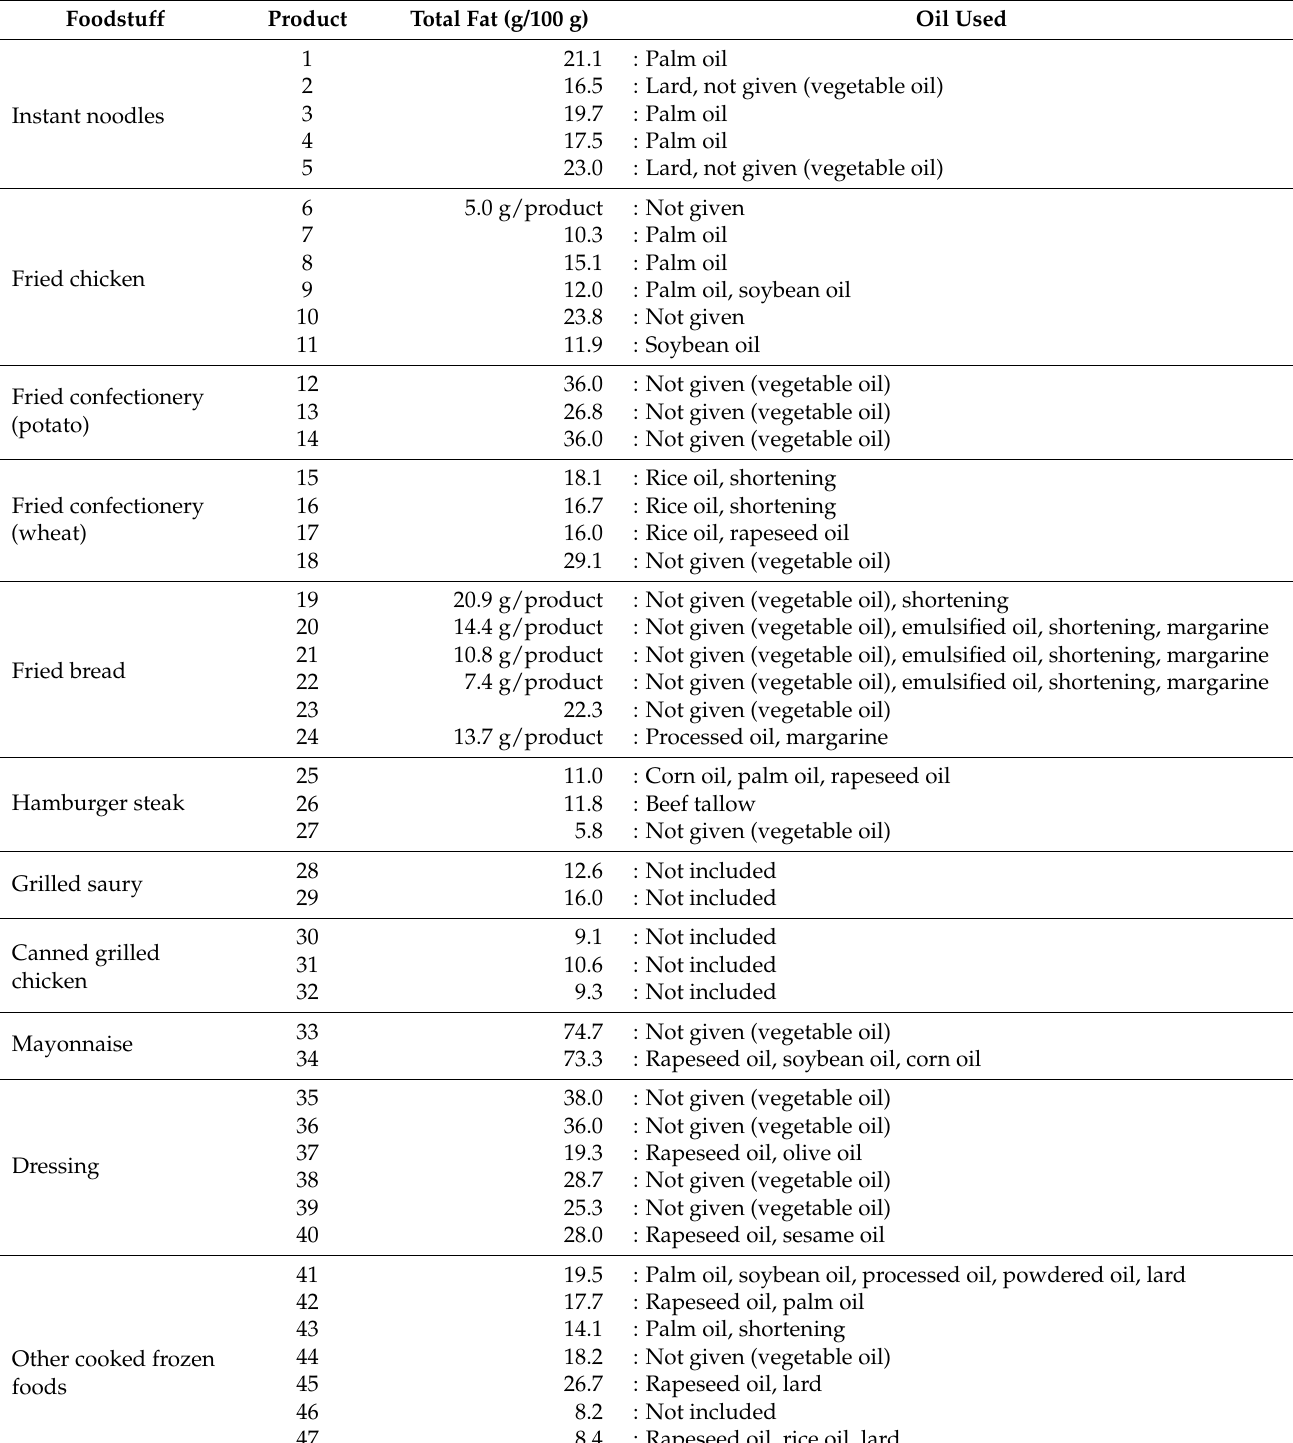
Table 1. Analyzed food samples and their basic